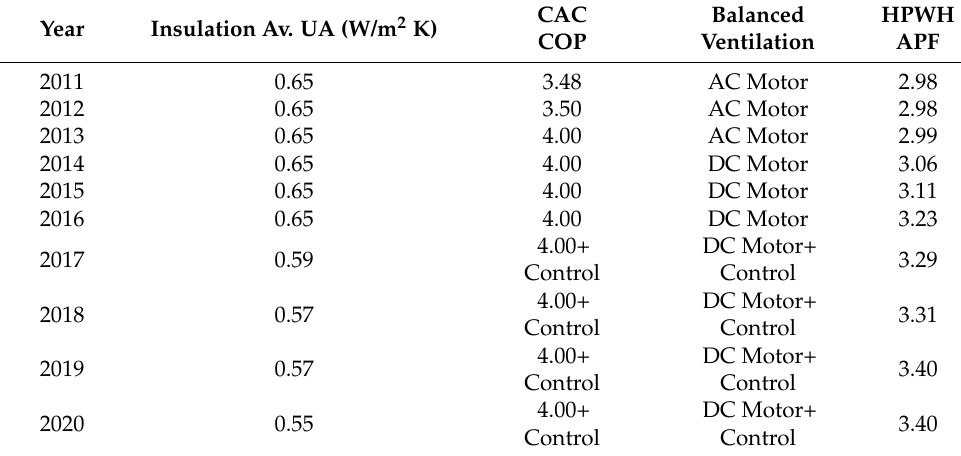
Figure 2. HEMS users by construction year. Table 3. Annual household and facility specification.